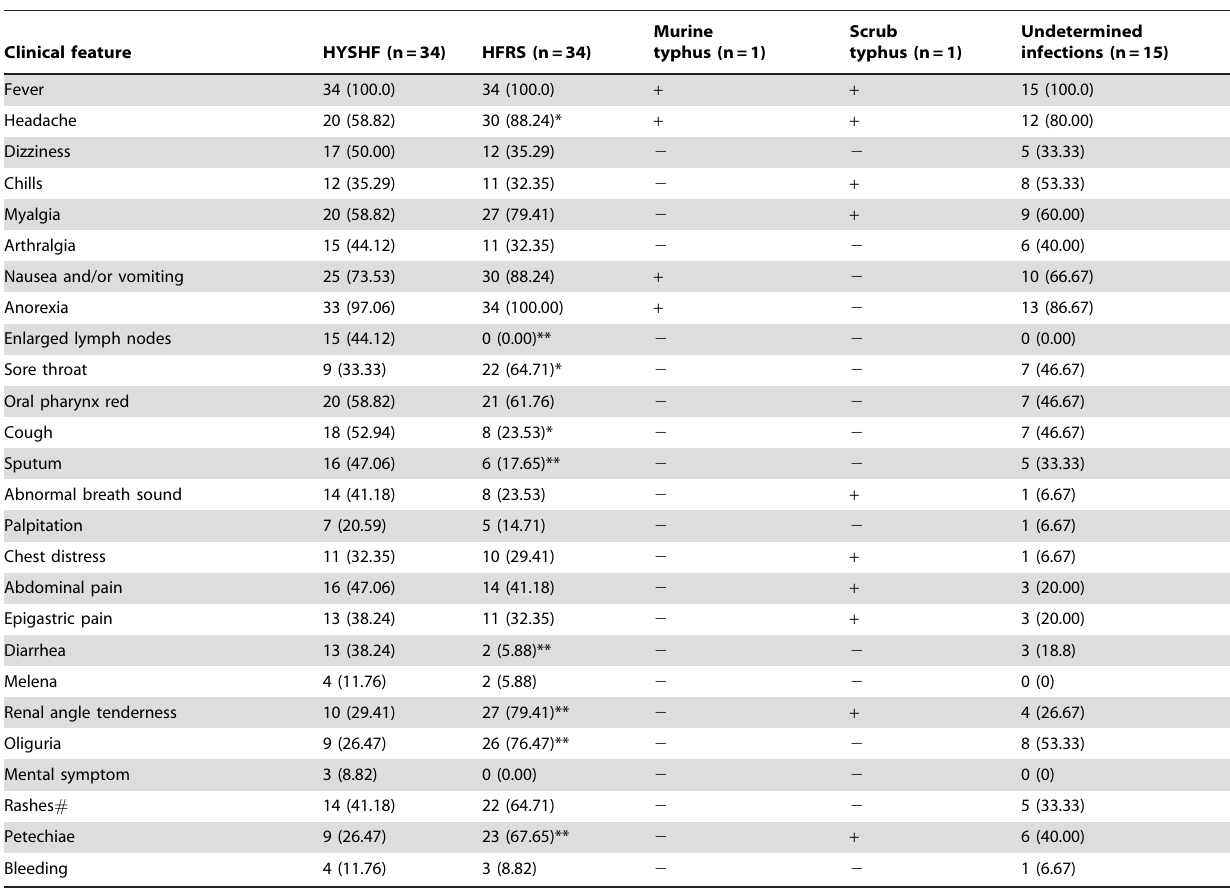
Table 4. Clinical characteristics of patients with